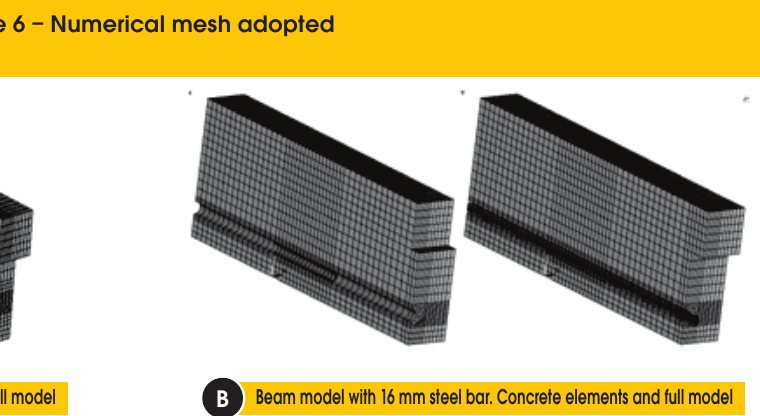
Figure 6 – Numerical mesh adopted